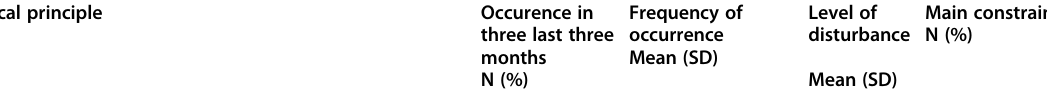
Table 2 All items, sorted by occurrence (descending); frequency scale (five-point Likert scale): 1 = nie ( “ never ” ), 2 = seltener als monatlich ( “ less then monthly ” ), 3 = monatlich ( “ monthly ” ), 4 = wöchentlich ( “ weekly ” ), 5 = mehrmals wöchentlich ( “ several times per week ” ); level of disturbance (five-point Likert scale): 1 = nicht ( “ not ” ), 0 = wenig ( “ a little ” ), 3 = mittelmäßig ( “ moderatly ” ), 4 = ziemlich ( “ quiet ” ), 5 = sehr ( “ a lot ”